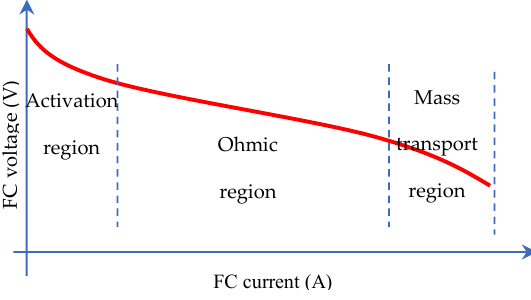
Figure 2. Nonlinear i – v characteristic of the fuel cell.